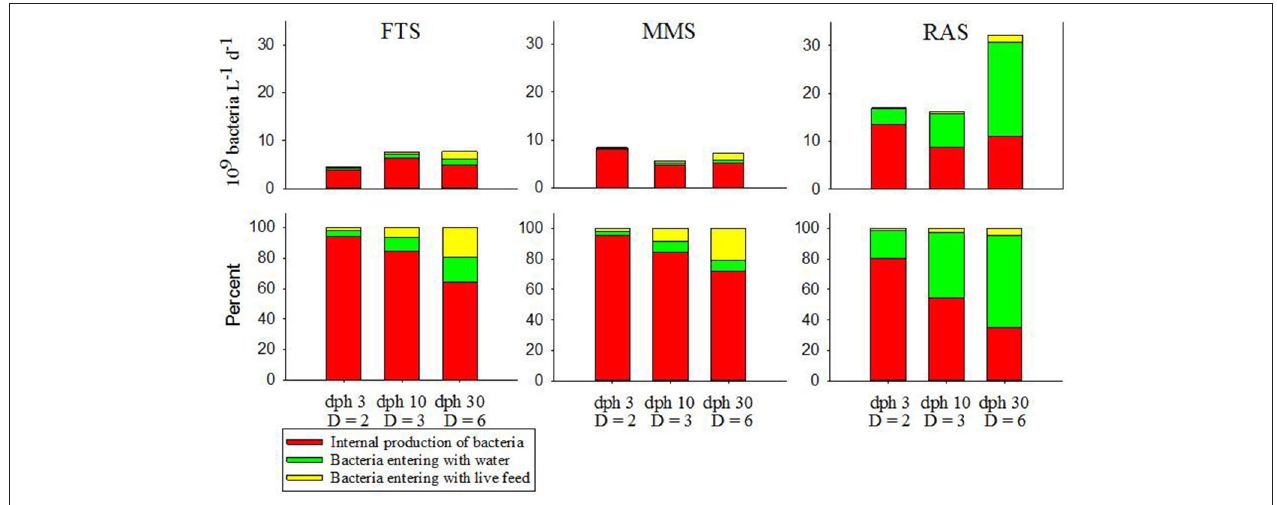
FIGURE 3 | Flows of bacteria to larval tanks per day from the principle external sources and the internal growth of bacteria in the rearing tanks in three water management systems for selected days post hatch (dph) of Atlantic cod. Different stages during the first feeding period have different tank dilution rates (D, tank volumes exchanged d − 1 ) and different live food (3 and 10 dph with rotifers and 29 dph with Artemia ). Top panels show absolute numbers and bottom panels show